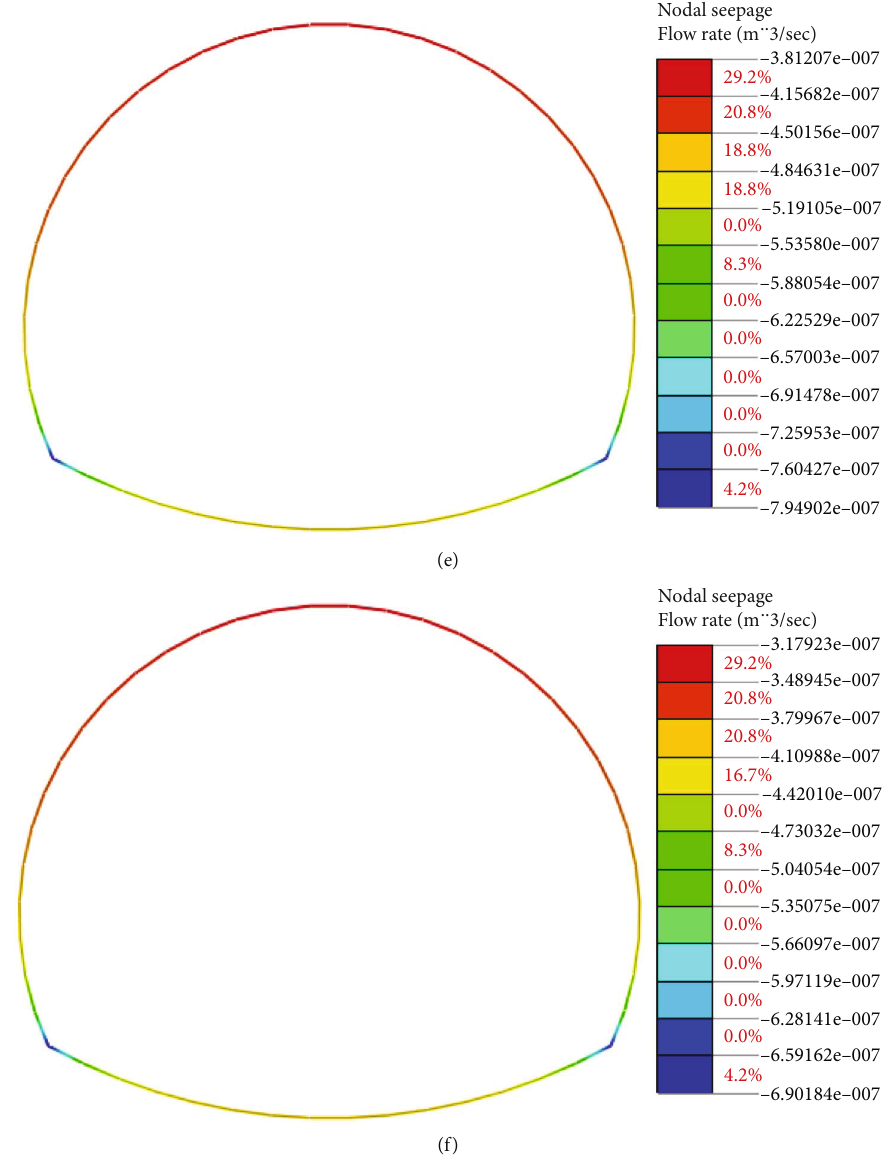
Figure 8: Cloud map of water surges: (a) no grouting, (b) grout 1m, (c) grout 3 m, (d) grout 5m, (e) grout 7 m, and (f) grout 9m. Table 3: Water surge per meter of